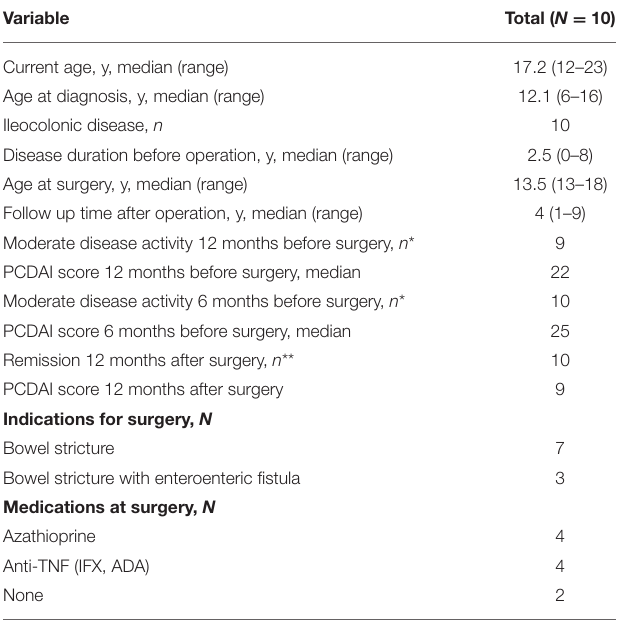
TABLE 1 | Patients’ demographic and clinical